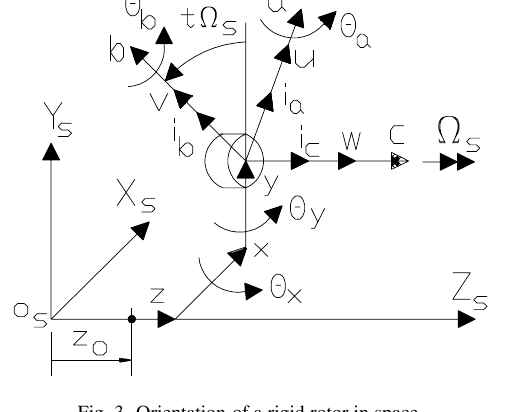
Fig. 3. Orientation of a rigid rotor in space.